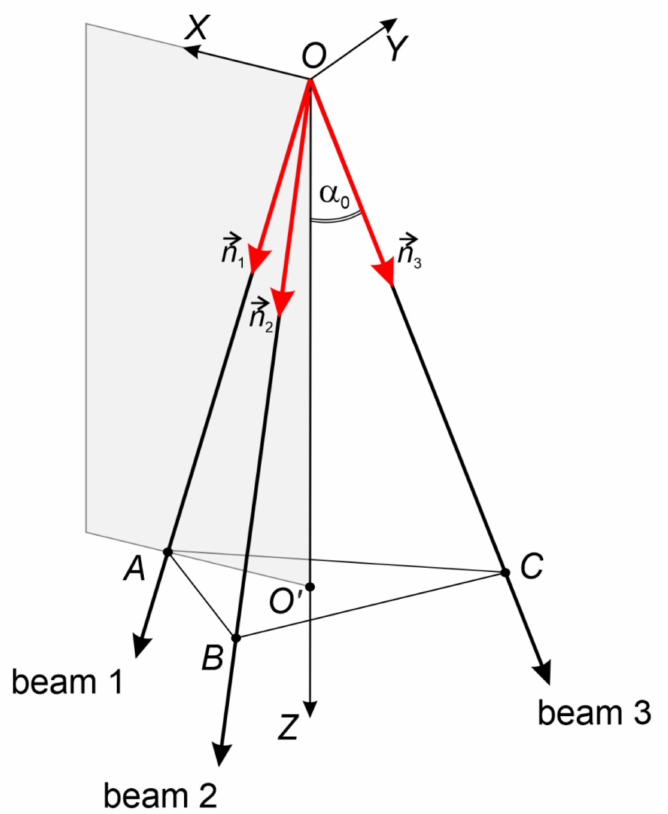
Figure 1. The coordinate system and main notations for three-beam ADCP configuration. Point O corresponds to the device head. Axis X lies in the plane